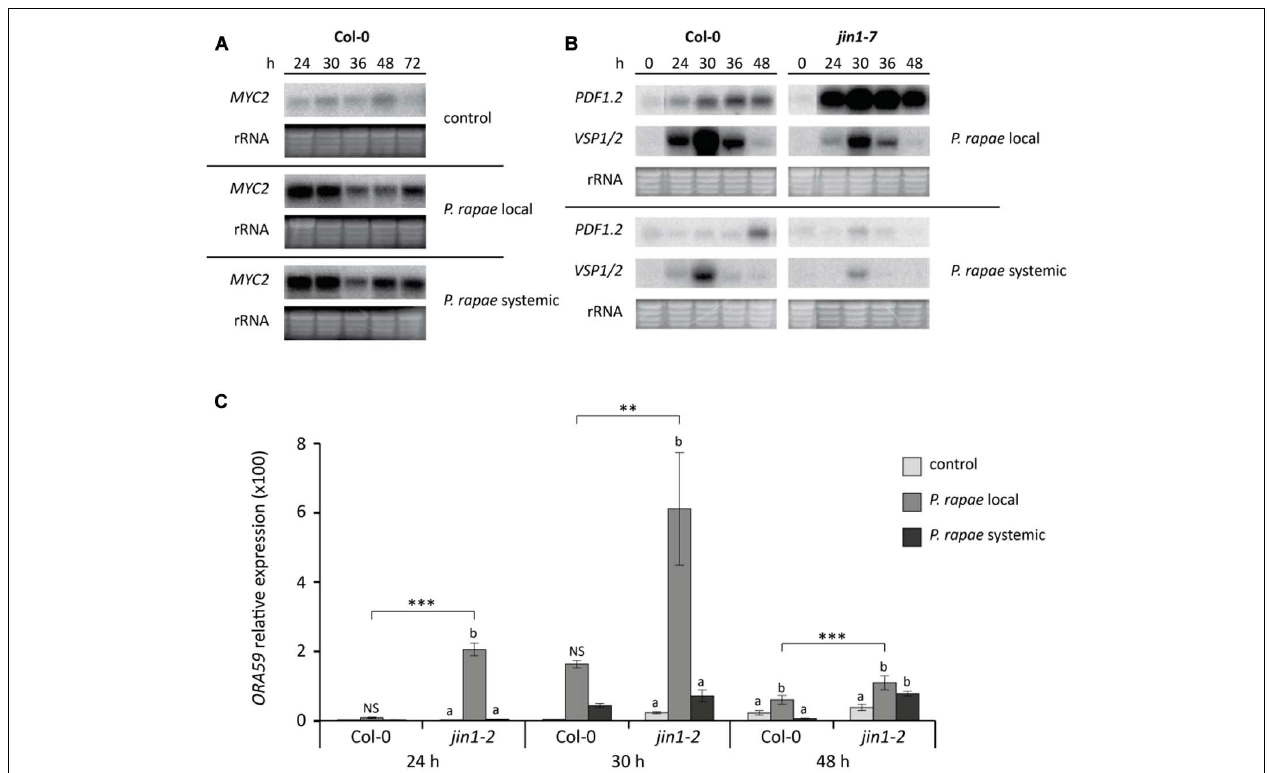
FIGURE 1 | Differential JA responses in Col-0 and MYC2-impaired jin1 plants in local damaged and systemic undamaged leaves upon herbivory by P. rapae . (A) Northern blot analysis of MYC2 transcript levels in non-infested (control) and P. rapae -infested Col-0 plants. First-instar larvae were allowed to feed for 24 h after which they were removed ( t = 24 h). Subsequently, damaged ( P. rapae local) and undamaged ( P. rapae systemic) leaf tissue was harvested for gene expression analysis. (B) Northern blot analysis of JA-responsive PDF1.2 (marker for ERF-branch) and VSP1/2 (marker for MYC-branch) gene expression in damaged ( P. rapae local) and undamaged